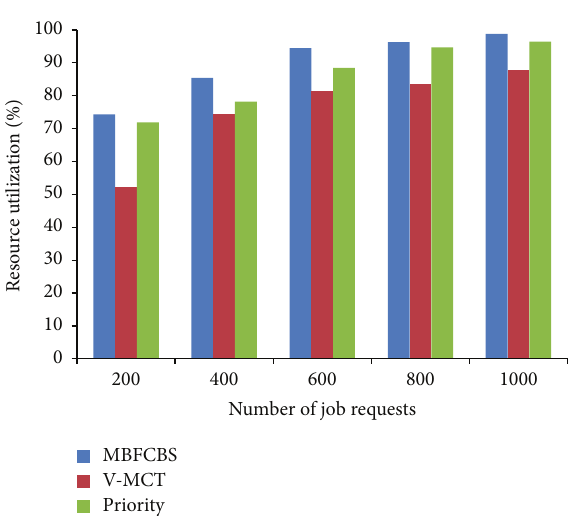
Figure 10: Comparison of total completion time.